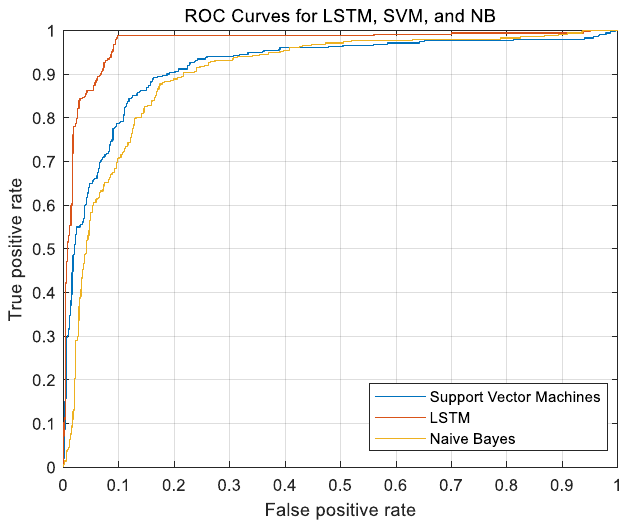
Figure 10. ROC curves for three models.